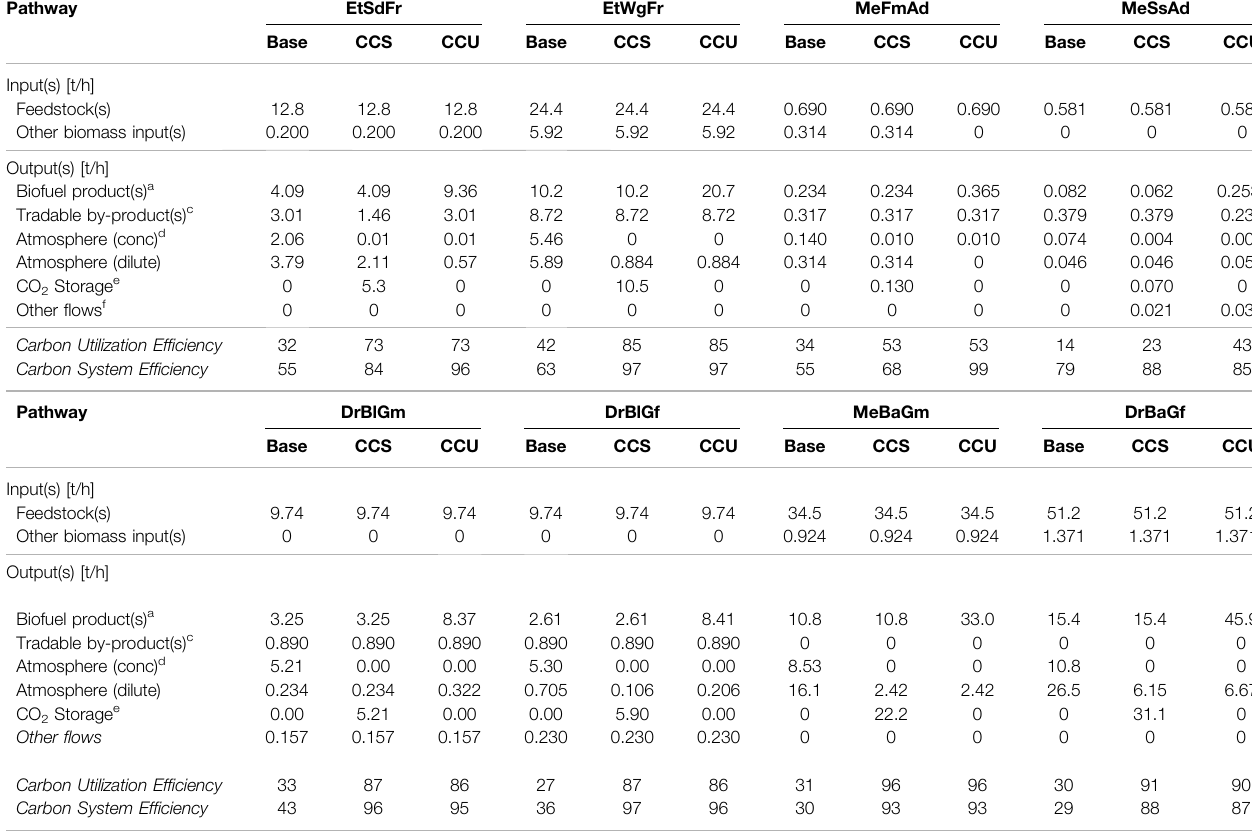
TABLE6| Biogeniccarbon fl owsforfermentation(EtSdFr,EtWgFr),anaerobicdigestion(MeFmAdandMeSsAd)andgasi fi cationpathways(DrBlGm,DrBlGf,MeBaGmand DrBaGf). See Table 1 for explanation of pathway abbreviations. Pathway